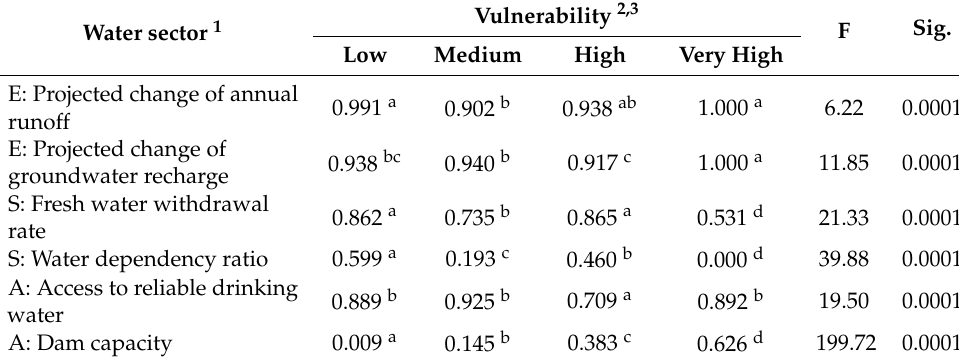
Table 4. Climate change vulnerability classes by water sector vulnerability indicators.